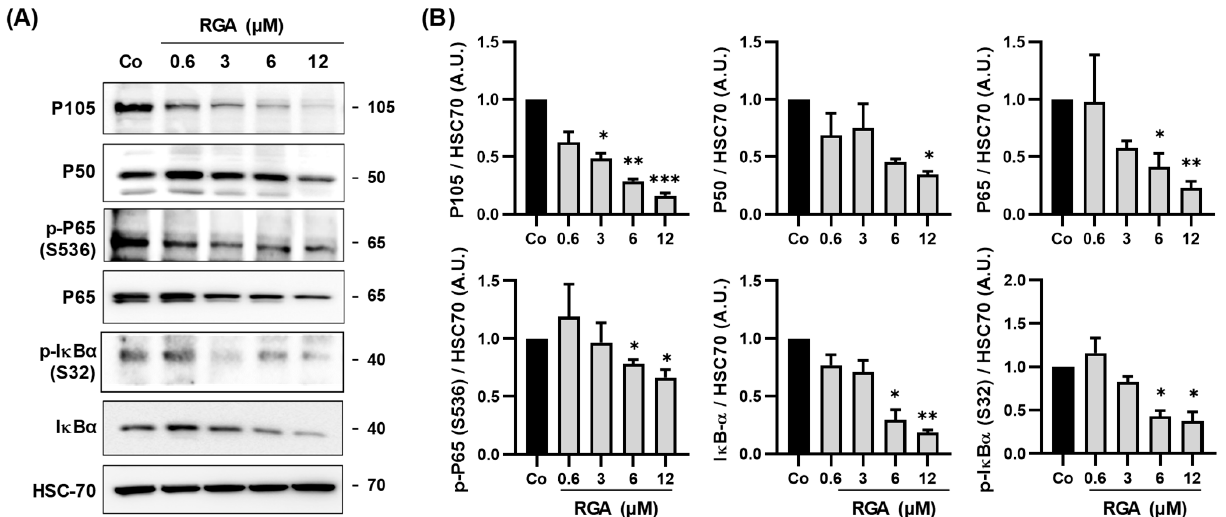
Figure 3. RSV/ ω -3 fatty acids combination decreases NF κ B complex protein expression. ( A ) Immunoblot analysis of P105, P50, phospho-P65, (p-P65), P65, phospho-I κ B α (p-I κ B α ), I κ B α in RGA- treated ARPE-19 cells with increasing concentration (0.6, 3, 6, 12 µ M) or with vehicle (Co) for 24 h. HSC ‐ 70 was used as a loading control. ( B ) Densitometry quantification of western blotting. Data are expressed as the mean fold induction ± SEM of three independent experiments. p values were determined by a one ‐ way ANOVA followed by Tukey’s multiple comparison test of treatments vs. control. * p < 0.05, ** p < 0.01 and *** p < 0.001.